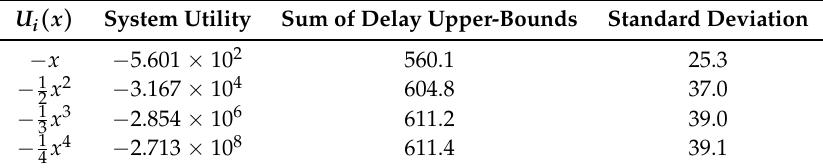
Table 3. The system utility, assigned intermediate deadline sum (i.e., total delay upper-bound) and standard deviation, with different utility functions, by the non-cooperative framework in Section